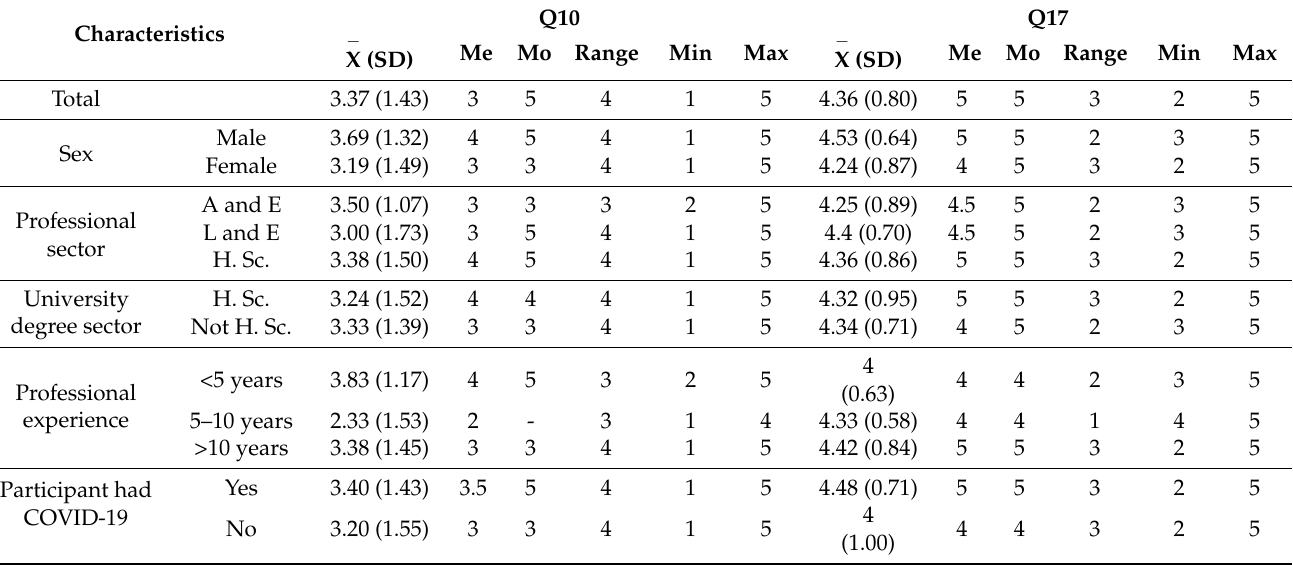
Table 9. Centrality and dispersion of Likert type questions 10 and